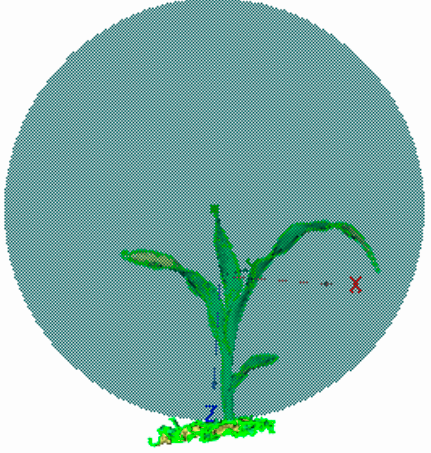
Figure 4. Calculation method for plant height based on the fitting sphere.